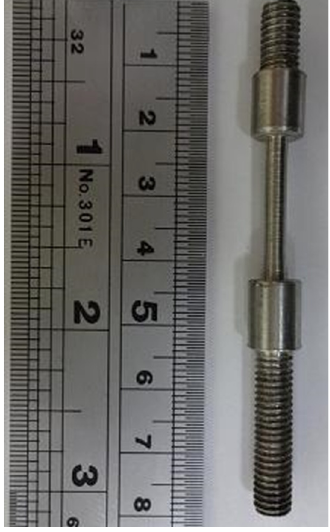
Fig. 5. The previous suspension